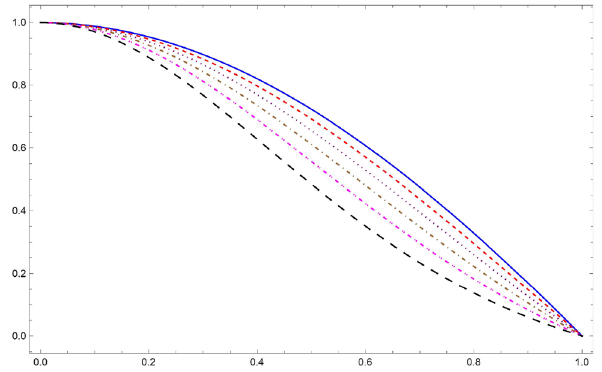
Fig. 1 ˜ P / ˜ P c vs x for of y = 0 . 05 solid (blue) curve, y = 0 . 10 dashed (red) curve, y = 0 . 15 dotted (purple) curve, y = 0 . 20 dot-dashed (brown) curve, y = 0 . 25 doubled dot-dashed (magenta) and y = 0 . 30 longdashed(black)curveinthefirstcase,takingasseedtheFSsolution, and with the same original complexity factor